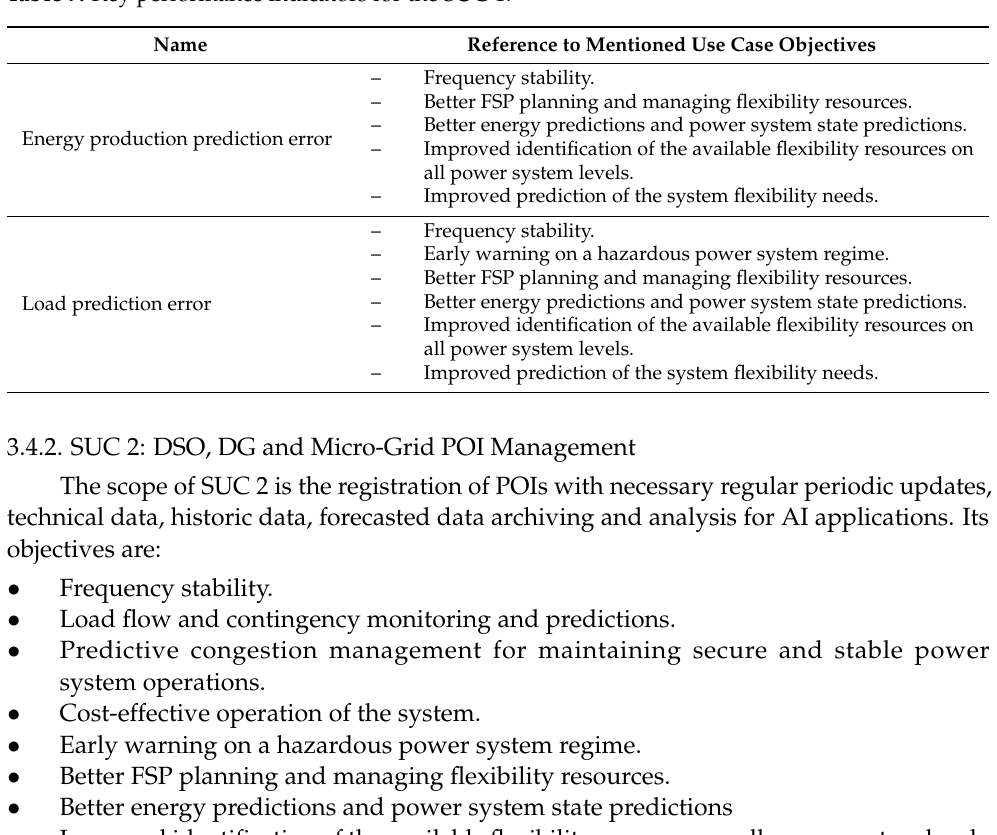
Table 7. Key performance indicators for the SUC